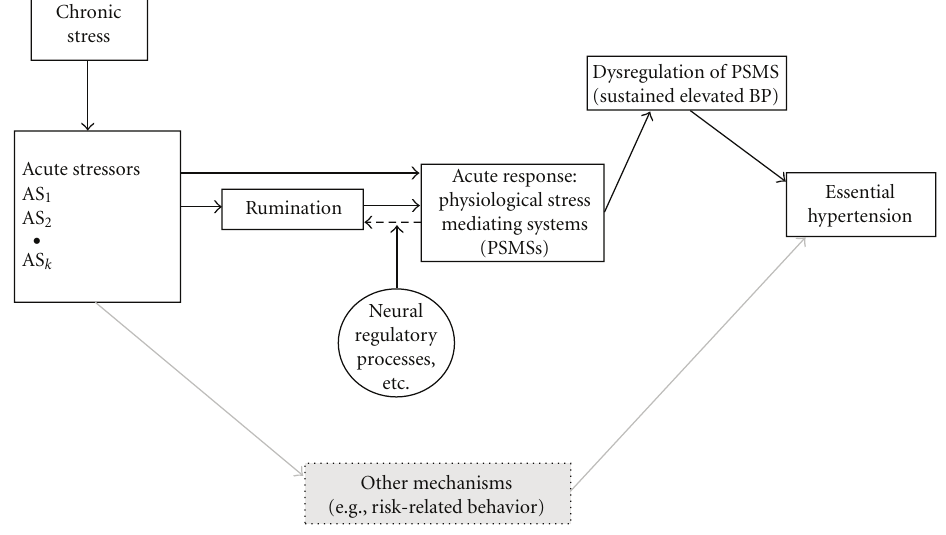
Figure 1: Schematic of the “chronic stress—rumination—HTN”